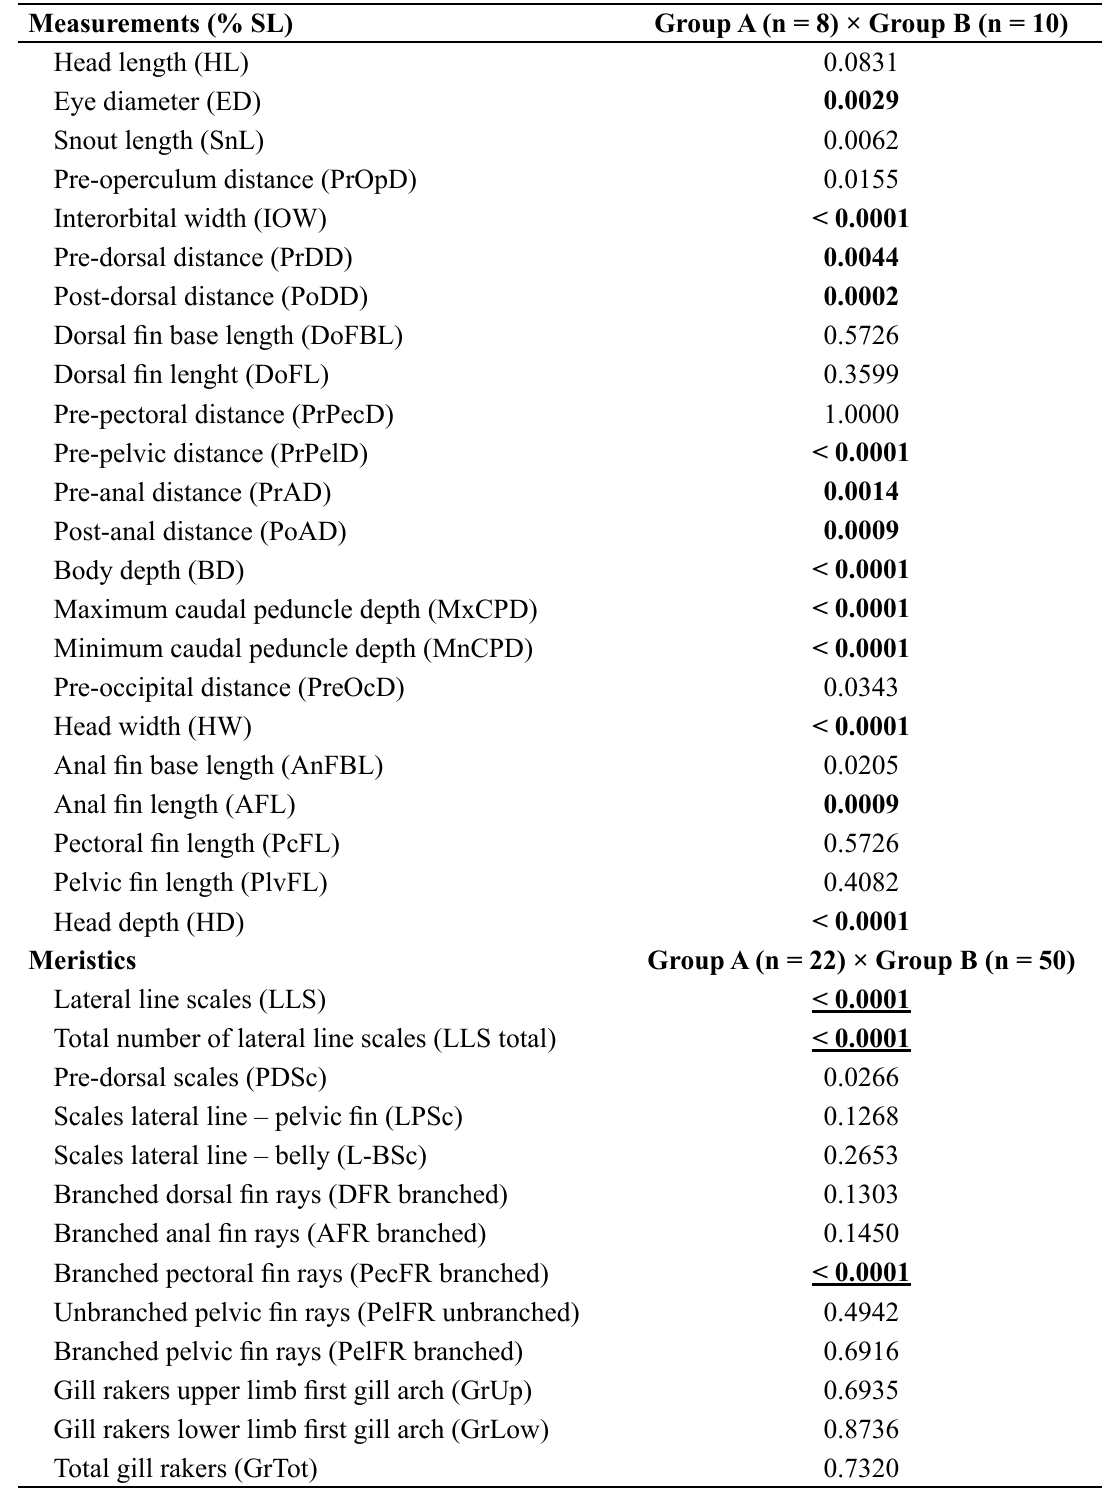
Table 1. Results of the MWU tests with Bonferroni correction on measurements (% SL) of specimens of similar size classes (46.4–53.8 mm), and on meristics of all specimens, on the two groups of Enteromius Cope, 1867. Significant values (α = 0.05) are in bold; highly significant values (α = 0.001) are in bold and